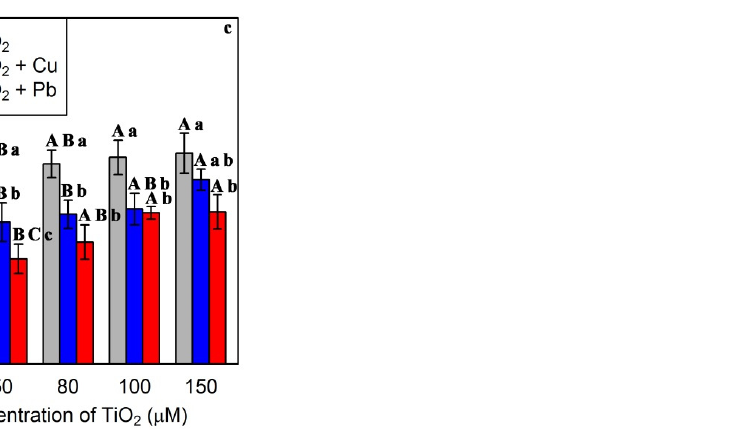
Figure 3. Impact of the combination of TiO 2 NPs with 100 µ m Cu and 100 µ m Pb on shoot dry weight (DW) ( a ), root dry weight (DW) ( b ) and shoot length ( c ) in A. pygmaea . Each data point is the mean ± SE of five replicates. The treatments contained various levels of TiO 2 NPs alone or in combination with 100 µ M Cu and 100 µ M Pb. The capital letters show statistically significant differences across various levels of TiO 2 NPs alone or in combination with 100 µ M Cu and 100 µ M Pb (the bars with the same colors), while the lowercase letters show statistically significant differences within each level of TiO 2 NPs alone or in combination with 100 µ M Cu and 100 µ M Pb (the bars with different colors), according to Tukey (cid:48) s test ( p <